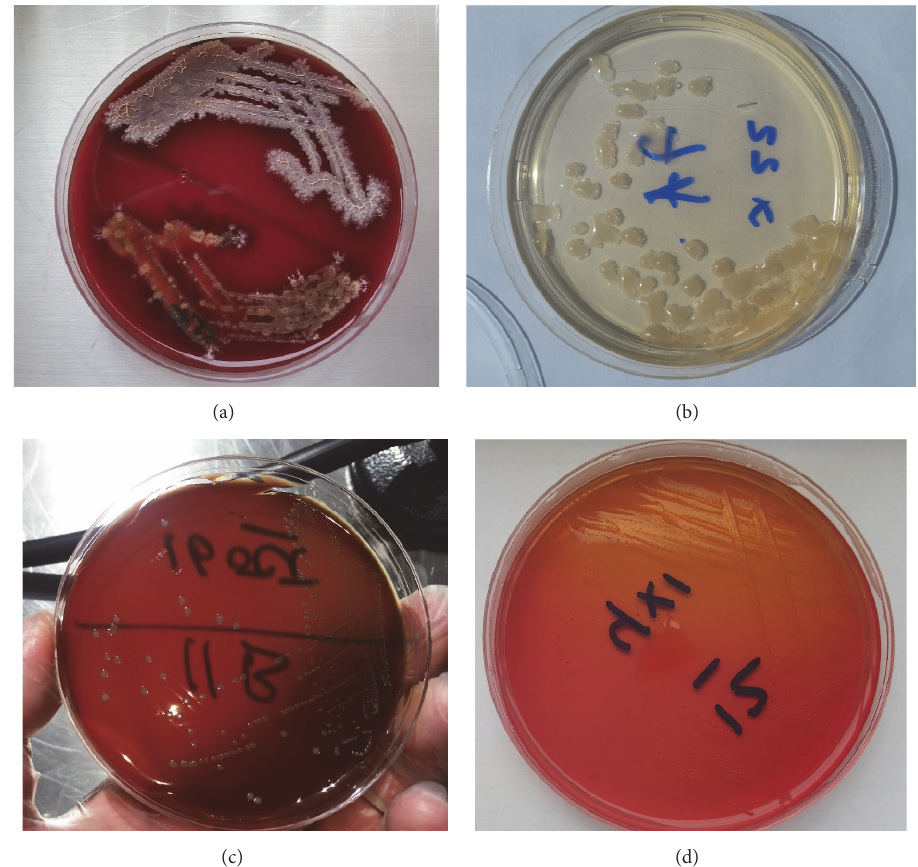
Figure 2: Growth in differential media. (a) Bacteria growing on a blood agar plate. (b) Bacteria growing on Sabouraud agar plate. (c) Bacteria growing on EMB agar. (d) Bacteria growing on Macconkey agar.